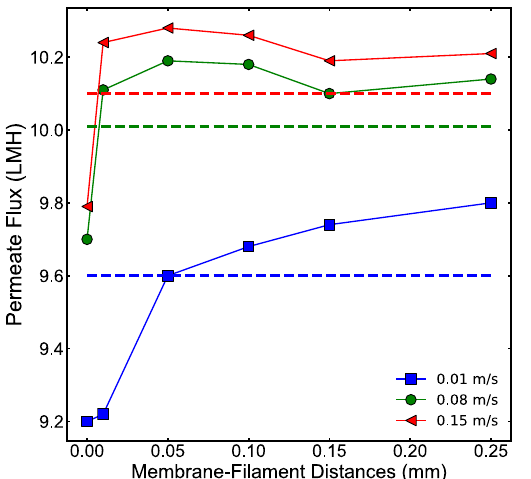
Figure 8. Water flux vs. membrane–filament distance for different crossflow velocities. A membrane with empty channels is used as a control and its flux is indicated with dotted lines. The spacer geometries are shown in Figure